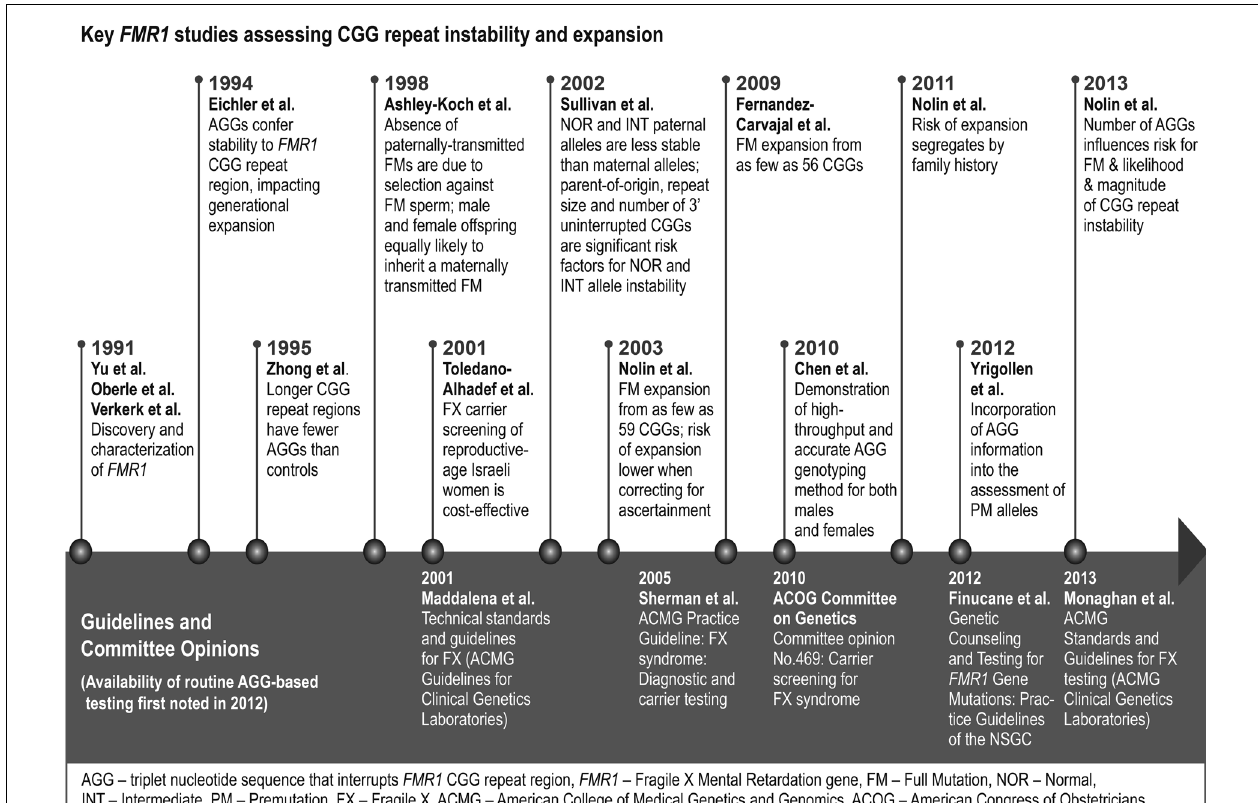
FIGURE 1 |Timeline for molecular advances and clinical impact ofAGG interruptions in the triplet repeat region of the FMR1 gene. The figure identifies several of the seminal publications in both basic and clinical research